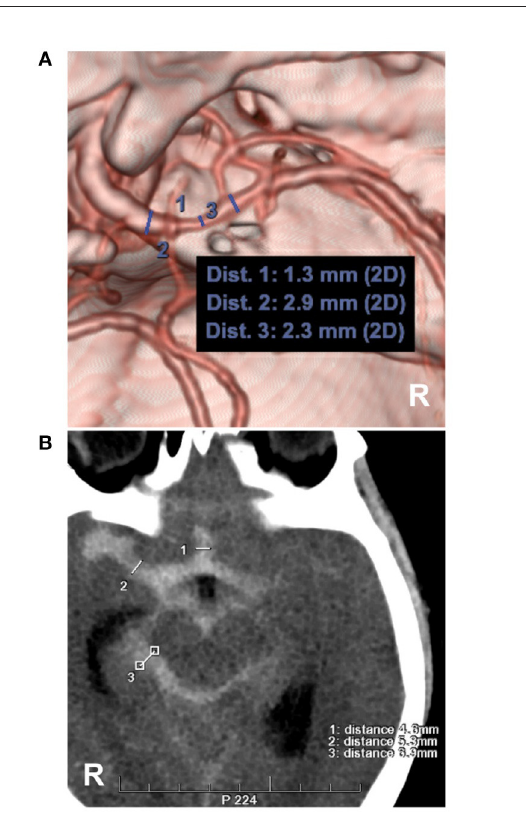
FIGURE6 Measurements of intracranial vasospasm and SAH thickness. (A) CTA showing the diameter measurement of the MCA. No. 1, 2 and 3 showing the diameters of the different locations of the MCA, the location of No. 1 had a moderate vasospasm (33–66%, 1.3/2.3 and 1.3/2.9). (B) CT showing the measurements of the Barrow Neurological Institute scale, No. 1, 2 and 3 showing